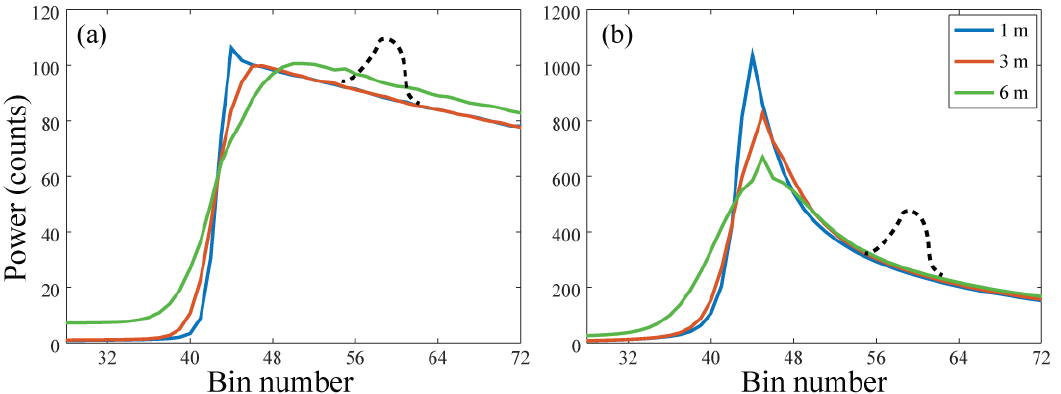
Figure 1. ( a ) Typical Low Resolution Mode (LRM) waveform; ( b ) Typical Doppler Altimeter (DDA) waveform: the coloured lines show the shape for three different significant wave height (SWH) values; the black dashed line shows the potential land contribution near the coast. This will normally move towards the front of the waveform and become more prominent as the coast is